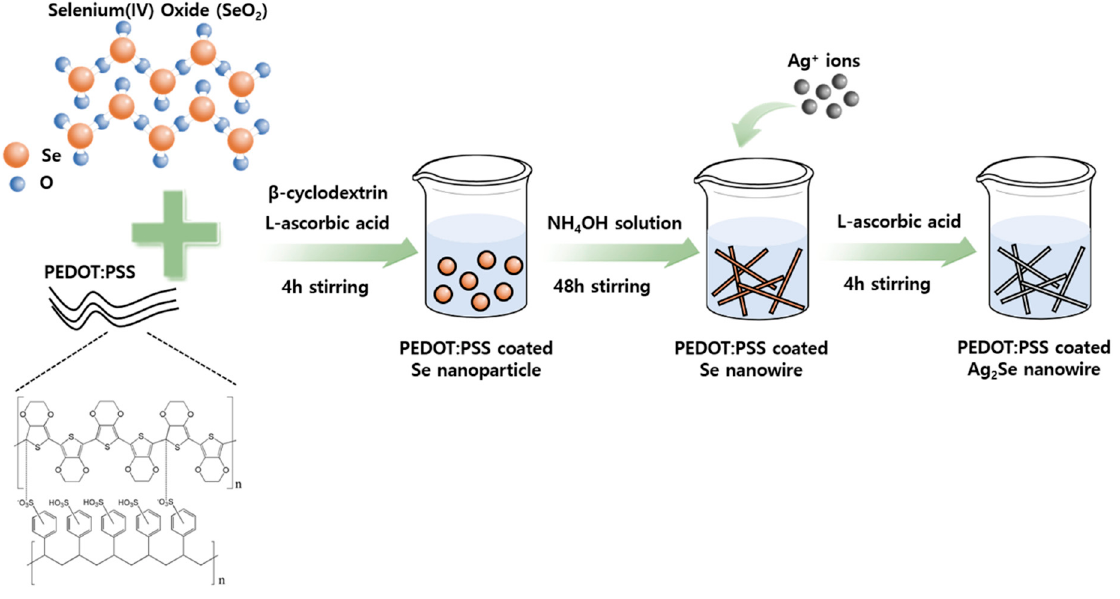
Figure 1. Schematic diagrams showing the preparation of the PEDOT:PSS-coated Ag 2 Se NWs. Se NWs, XRD, FE-SEM and FE-TEM were conducted and the results are presented in Figure S1. Thus, all of the XRD peaks for Se (Figure S1a) can be indexed as orthorhombic Se (JCPDS no. 86-2246), while the FE-SEM image (Figure S1b) confirms the presence of wire-like Se, and the high-magnification FE-TEM image (Figure S1c) clearly reveals the coating